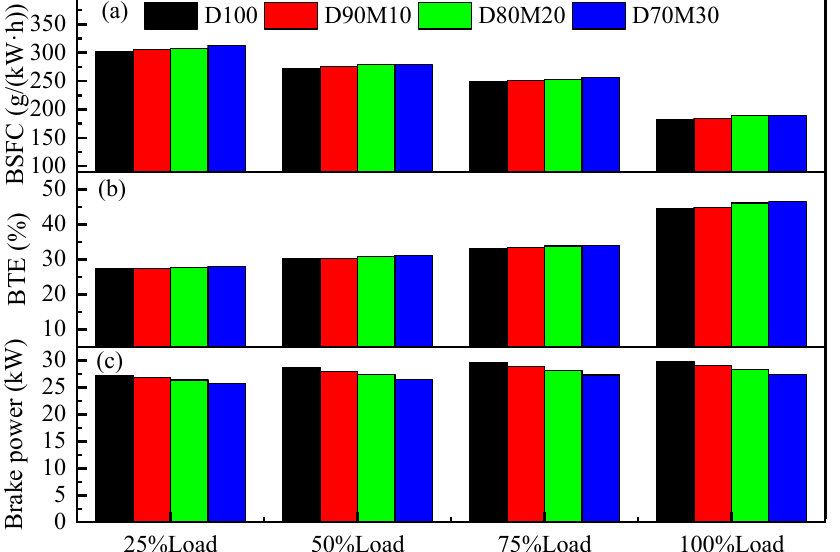
Figure 10. BSFC, BTE. and brake power of different proportions of diesel–methanol blended fuel under different load conditions. ( a ) BSFC, ( b ) BTE, ( c ) Brake power.